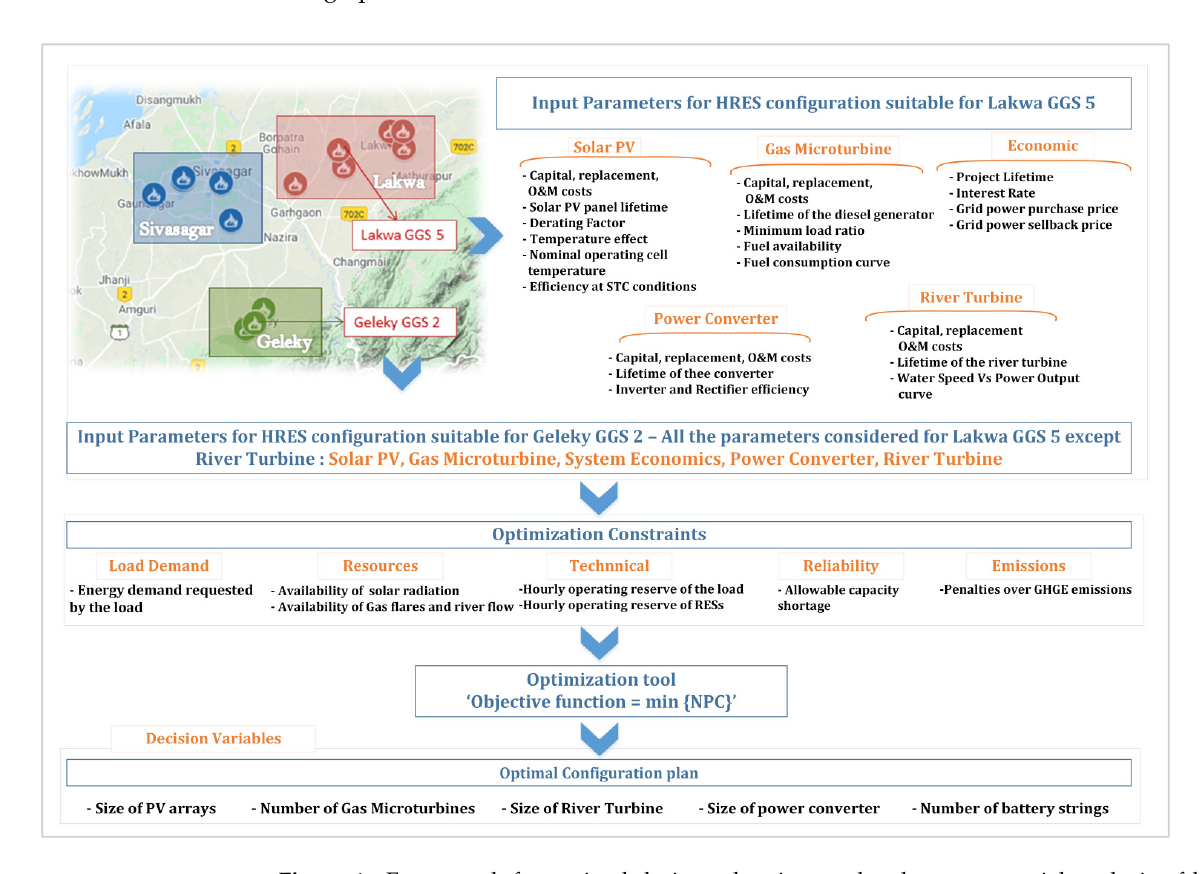
Figure 1. Framework for optimal design, planning, and techno-commercial analysis of hybrid renewable energy systems.